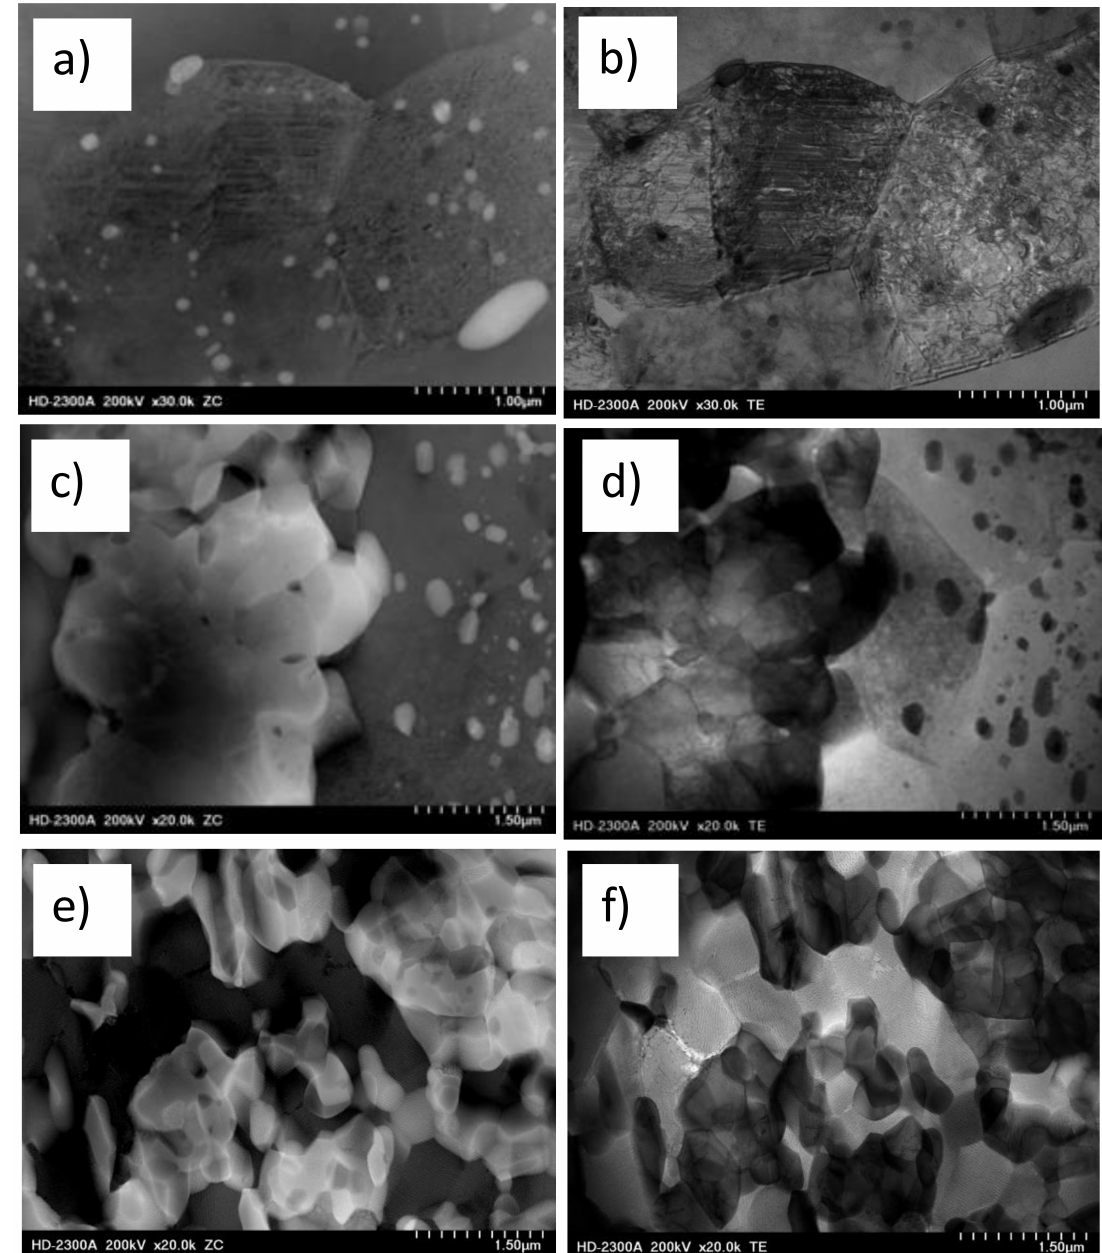
Figure 5. TEM images showing the characteristic microstructures of Al–Cu alloys after KoBo processing at λ = 98. The microstructures on the left side represent Z contrast (ZC) images, while the microstructures visible on the right side represent transmitted electron (TE) images. ( a , b ) Al 5 Cu alloy, ( c , d ) Al 25 Cu alloy, ( e , f ) Al 33 Cu